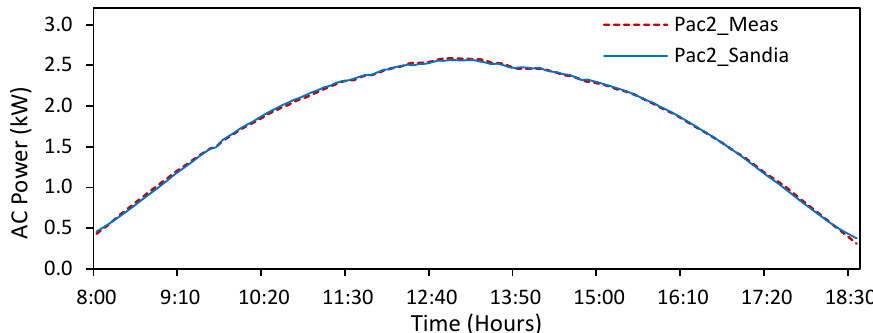
Figure 12. Measured and simulated AC power at the inverter output. Table 11. Regression metrics of AC Power model simulated for the three inverters. Parameters